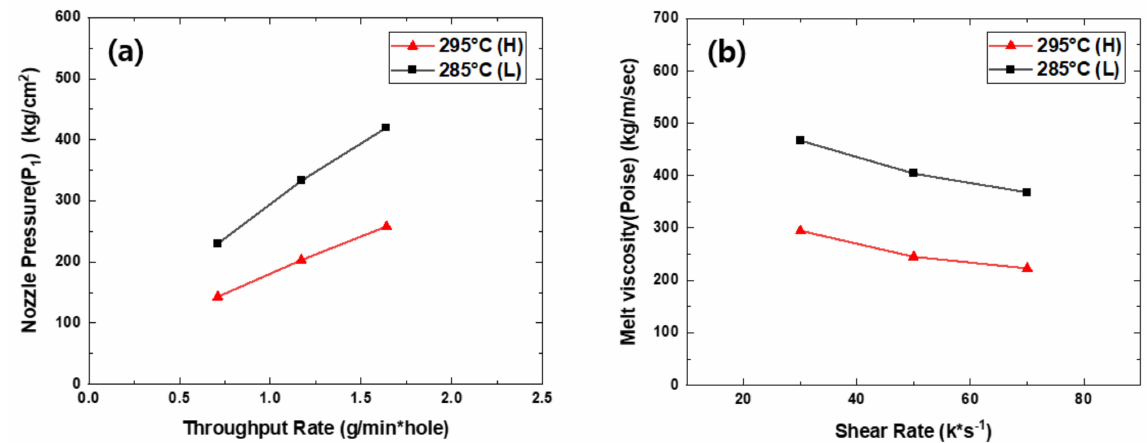
Figure 2. Relationship between ( a ) nozzle pressure ( P 1 ) and throughput rate and between ( b ) melt viscosity (poise) and shear rate for the TLCP resin in the spinning nozzle hole at the different spinning temperatures of 285 and 295 ◦